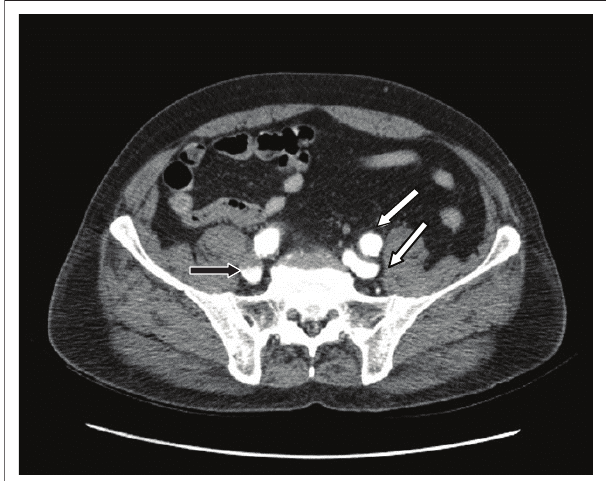
FIGURE 2: Axial contrast-enhanced computed tomography scan during the arterial phase showing opacification of the common iliac arteries and veins bilaterally, with similar attenuation (white arrows); layering of contrast was observed in the iliac veins (black arrow).